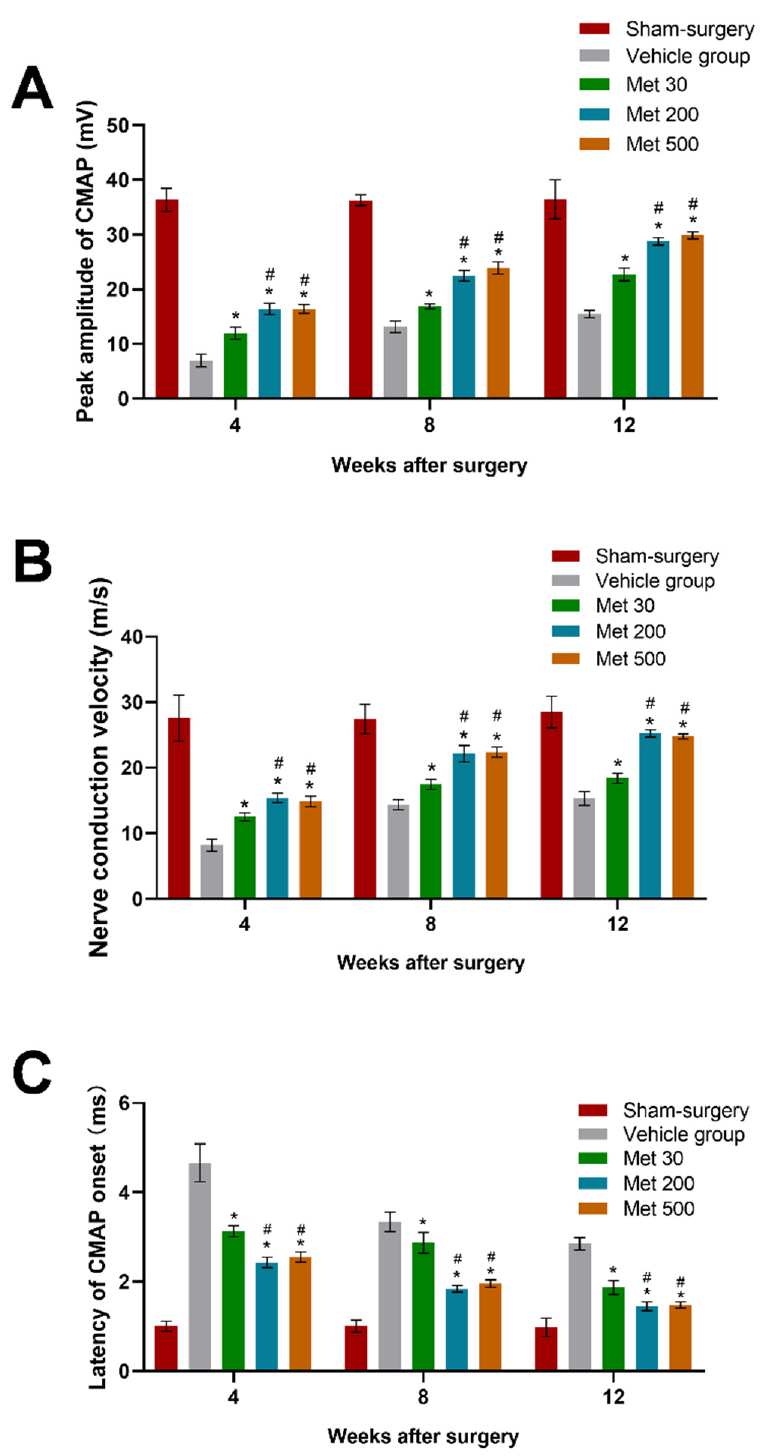
Figure 4. The result of electrophysiological tests at each point in time in each group. The peak amplitude of CMAP ( A ), nerve conduction velocity ( B ) and latency of CMAP ( C ) were recorded and expressed as the mean ± standard error of mean. * p < 0.05 for comparison to the vehicle group. # p < 0.05 for comparison to rats with metformin at low dose (30 mg/kg).